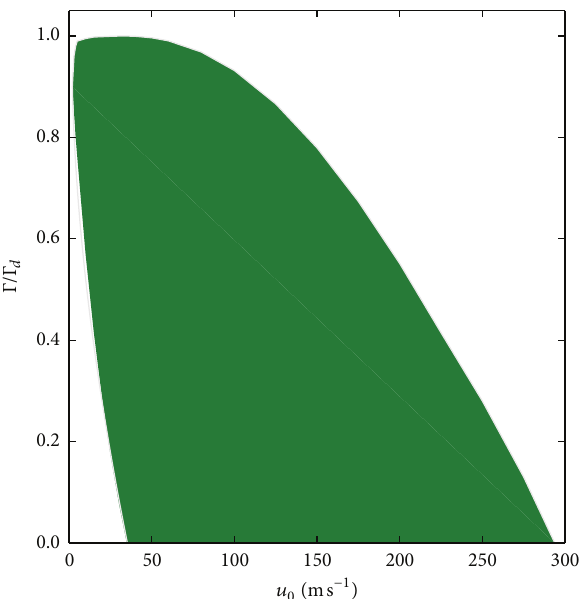
Figure 6: Domain of instability (filled) as a function of dimension- less temperature lapse rate Γ/Γ 𝑑 and vertically averaged zonal wind velocity 𝑢 0 .